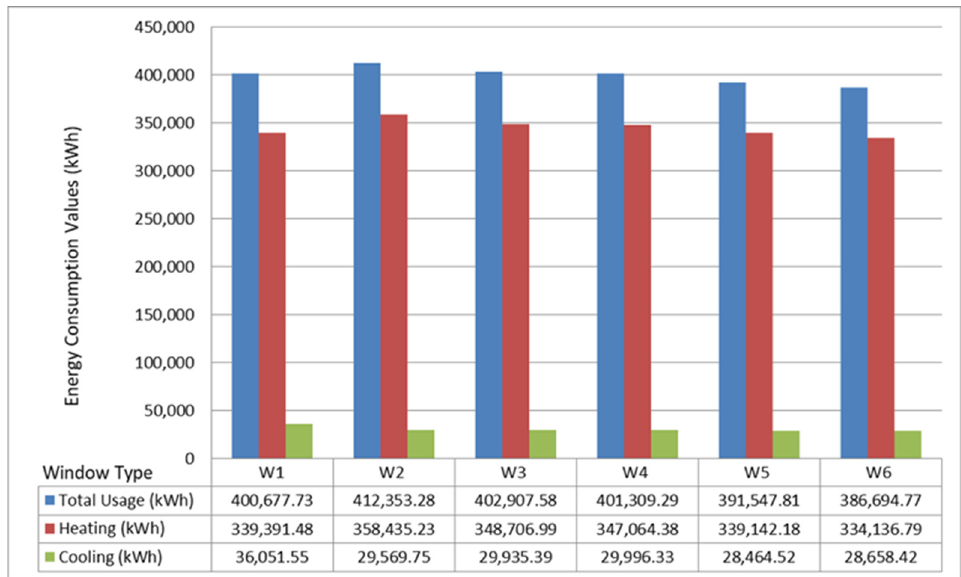
Figure 6. Energy consumption amounts due to improving the thermal properties of the transparent areas.